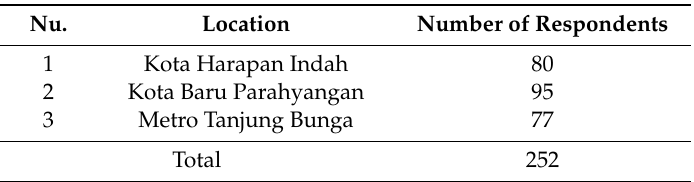
Table 3. The number of respondents.